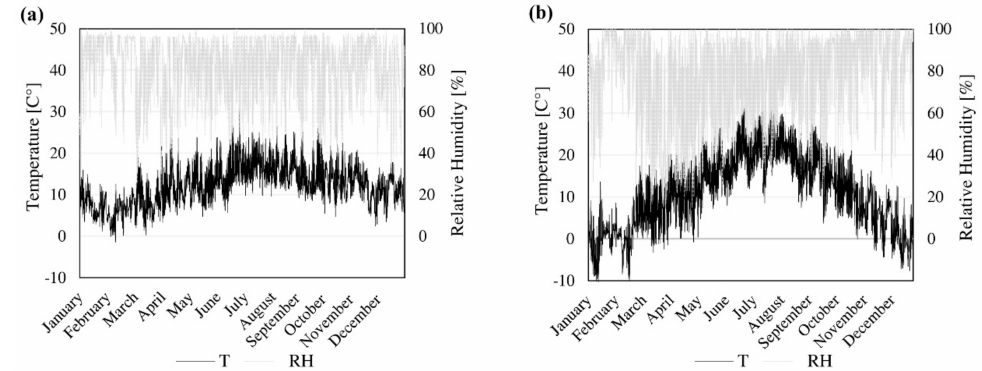
Figure 3. Climate data (temperature and relative humidity) of Monfero ( a ) and Turin ( b